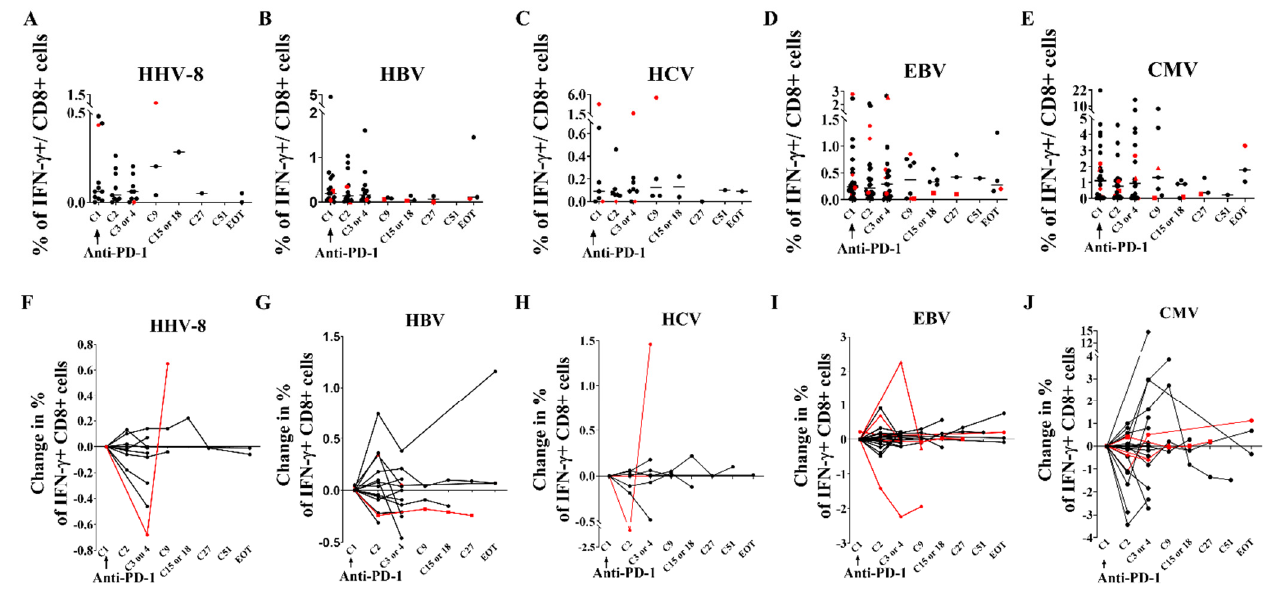
Figure 6. Anti-PD-1 therapy in PLWH with cancer does not significantly increase the frequency of virus-specific CD8 + cells. Thawed PBMC were stimulated during 6 h with viral peptides and then stained with intra-cellular anti-cytokine antibodies (anti-IFN- γ , anti-IL-2 and anti-TNF- α ). Virus-specific CD8 + T cells were defined as IFN- γ producing CD8+ T cells after viral stimulation. Frequencies of ( A ), HHV-8, ( B ), HBV, ( C ), HCV, ( D ), EBV, and ( E ), CMV-specific-CD8+ T cells overtime. Delta from baseline of ( F ), HHV-8, ( G ), HBV, ( H ), HCV, ( I ), EBV, and ( J ), CMV-specific CD8 + T cells under ICB. Red colors denote the patients with reservoir reduction. EOT: end of treatment. Experiments were monoplicates.